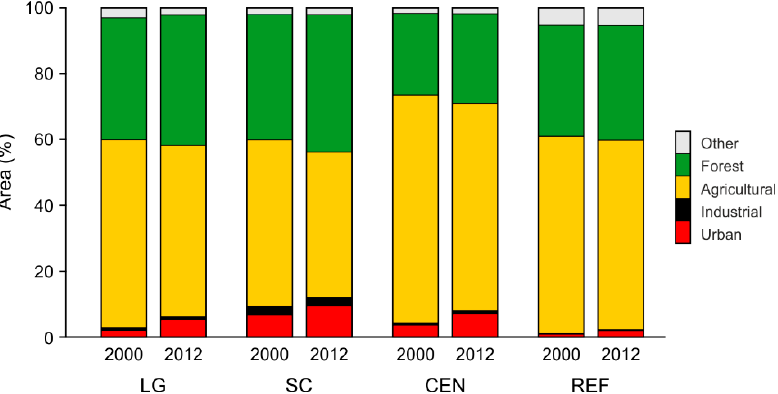
Figure 3. Change in the percentage of different categories of land cover between 2000 and 2012 in the four studied regions of Poland.